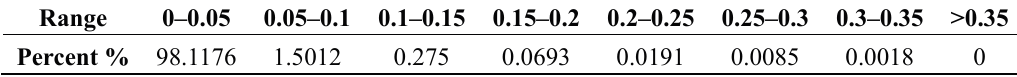
Table 6. Distribution range of the 2010